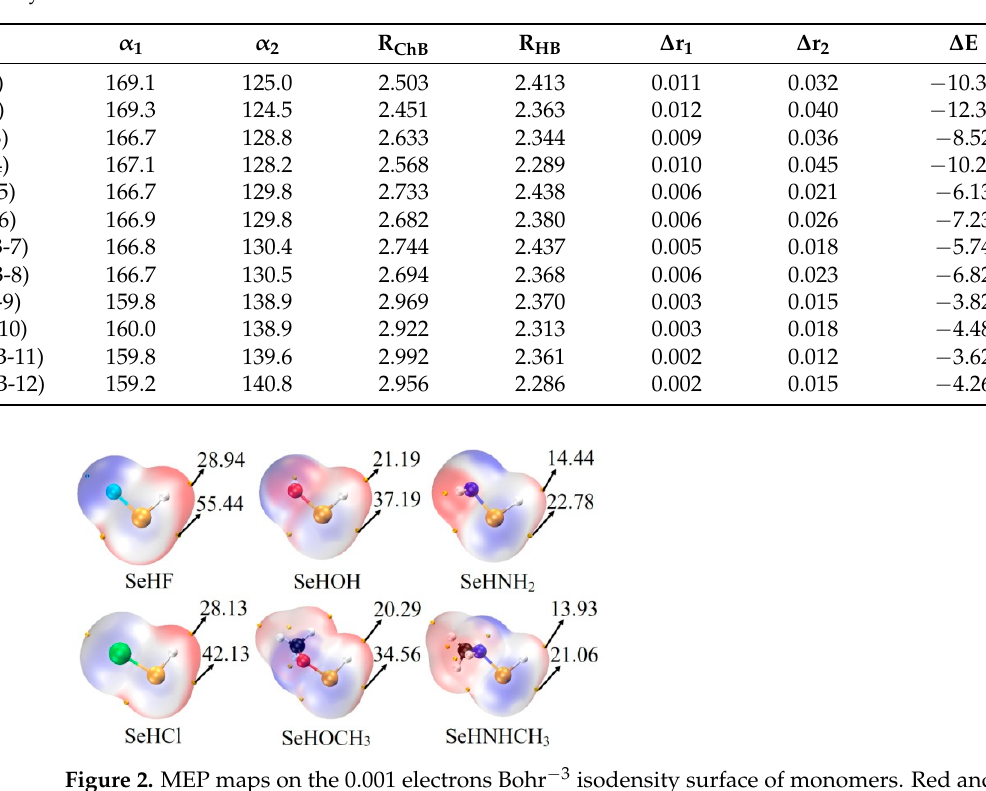
Table 1. Angles ( α , deg), binding distances (R, Å), change of bond length ( ∆ r, Å), and interaction energy ( ∆ E, kcal/mol) in the chalcogen-bonded dyads.